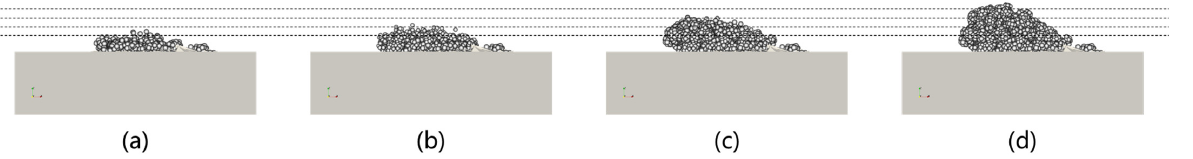
Figure 15. The width and height of the cladding layer of the HOTM simulation and the experiment. 4.2. Simulation of Microstructures According to the simulation results of the meso ‐ scale process, a multilayer micro ‐ structure simulation model can be established. The formation of the four ‐ layer structures is simulated based on the temperature field of the meso ‐ scale simulation, as shown in Figure 16. The Ti–6Al–4V thermal material parameters used for the CA simulation are listed in Table 3. By comparing the average grain length and width of the cross ‐ section (Table 4), it is found that the maximum relative errors are within 2.03% and 4.71%, respectively, and the simulation results are in good agreement with the experimental metallographic observa ‐ tions, which verifies the accuracy of the micro ‐ scale structure simulation. Table 3. The nucleation and grain growth simulation parameters. Parameter